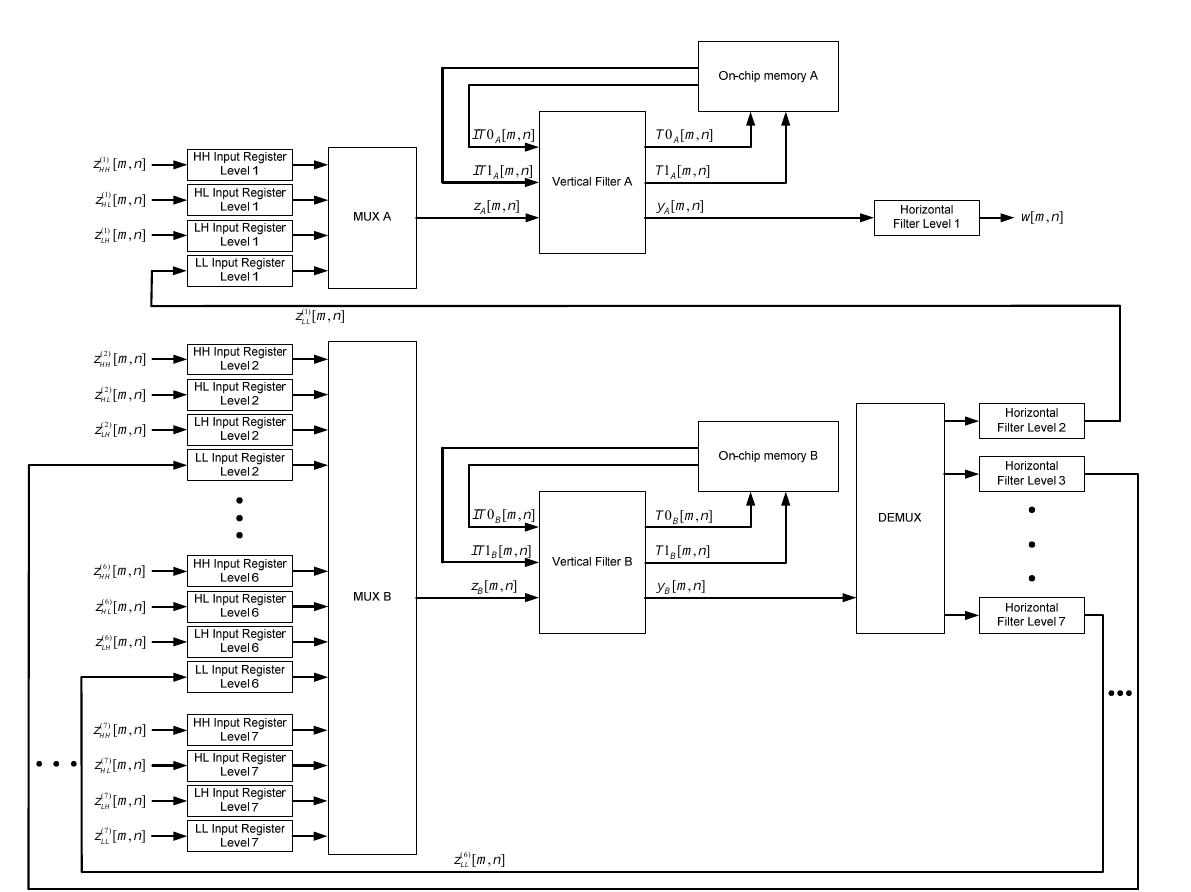
19 of 29 Table 7. FPGA synthesis results of various implementations of 5/3 filter on Altera FPGA EP4CE115F29C7. 1 ‐ D Inverse DWT 5/3 Filter @ 85 °C Unrestricted Frequency